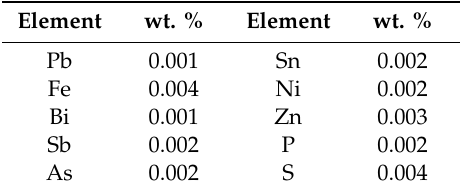
Table 1. Measured chemical composition (wt. %) of as-received pure Cu by inductively coupled plasma emission spectrometer and ONH analyzers. Element wt. %